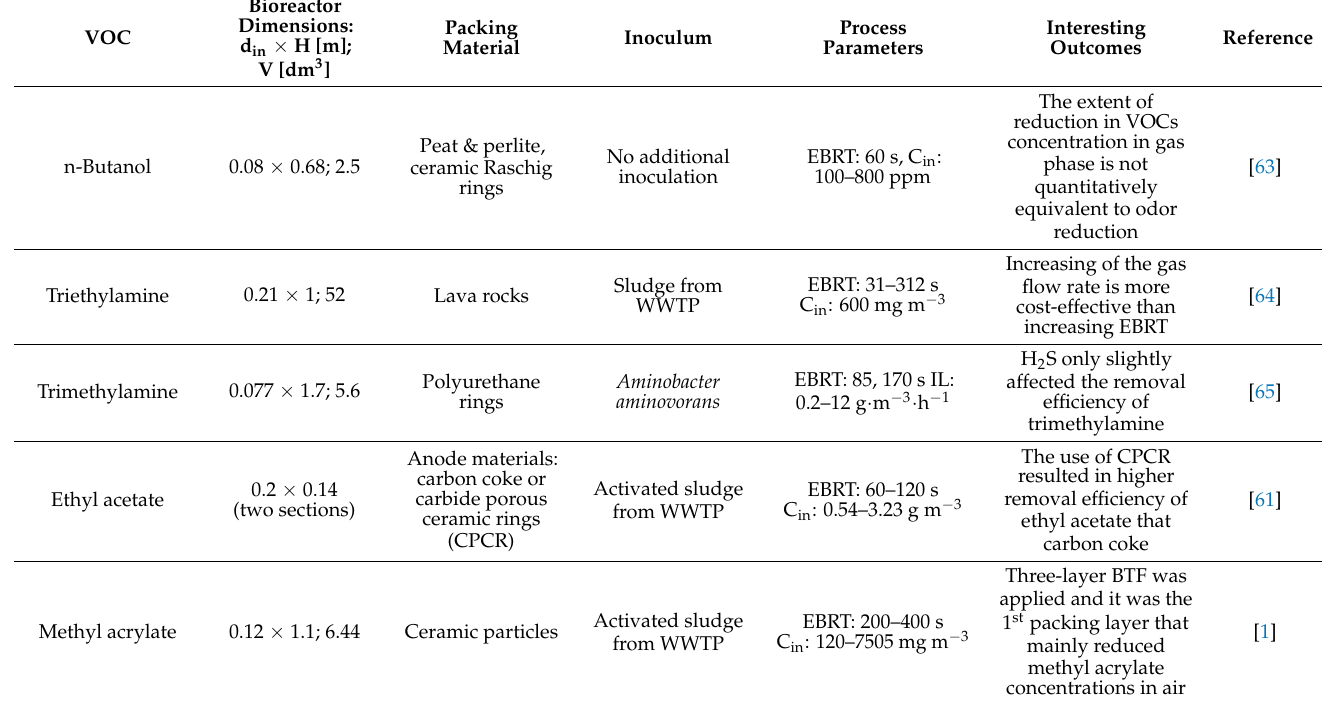
Table 2. Selected recent research on biotrickling filtration of single